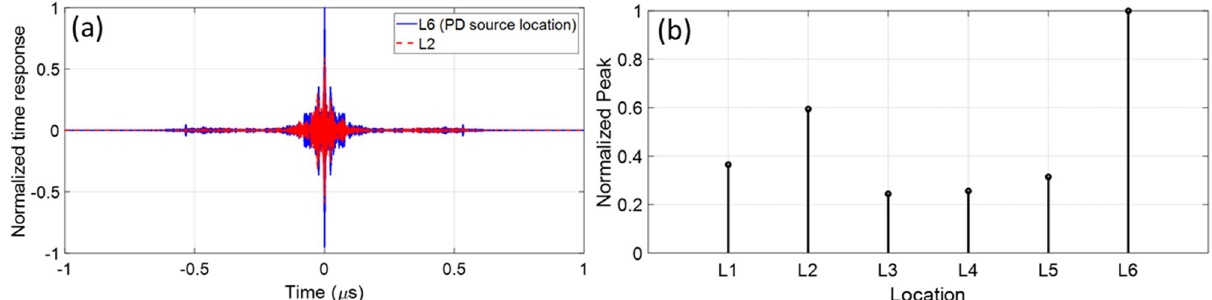
Figure 11. ( a ) Normalized time reversed responses for two guessed locations L 2 and L 6 . L 6 is the PD source location. ( b ) The normalized peak values of the time reversed response at the guessed locations L 1 to L 6 . The maximum peak occurs at L 6 , which corresponds to the PD source location. In this scenario the metallic object is included in the transformer tank model.